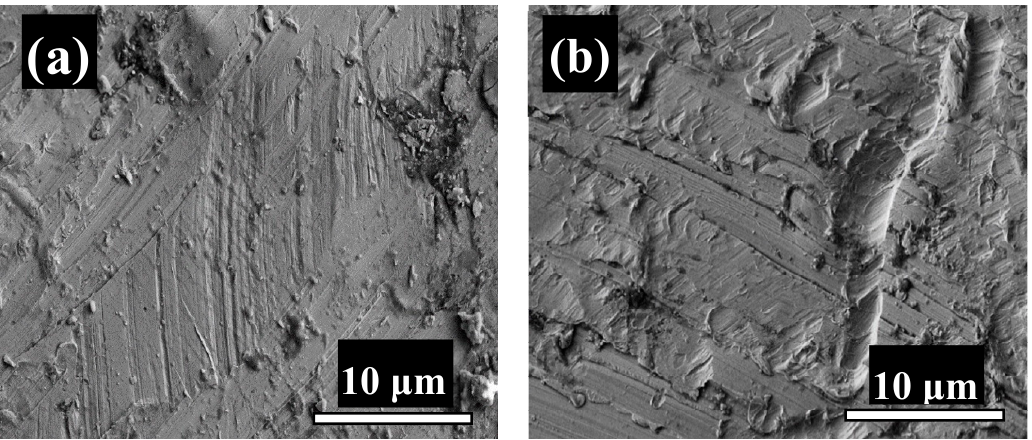
Figure 9. Fractography of Al–x wt.% TiC nanocomposite: x = ( a ) 0, and ( b ) 12.